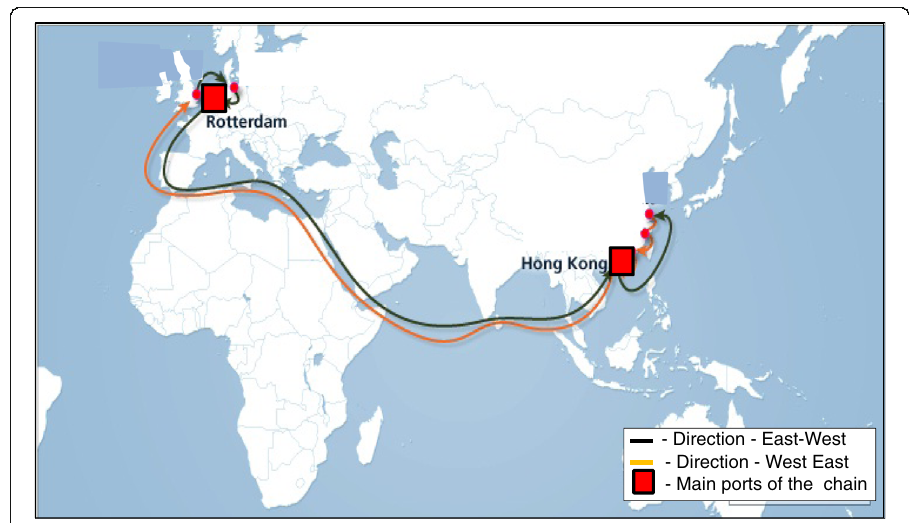
Fig. 5 Spatial/geographical layout of the trunk line/route of line container shipping network: Hong Kong- Rotterdam-Hon Kong (Ducruet and Notteboom 2012;